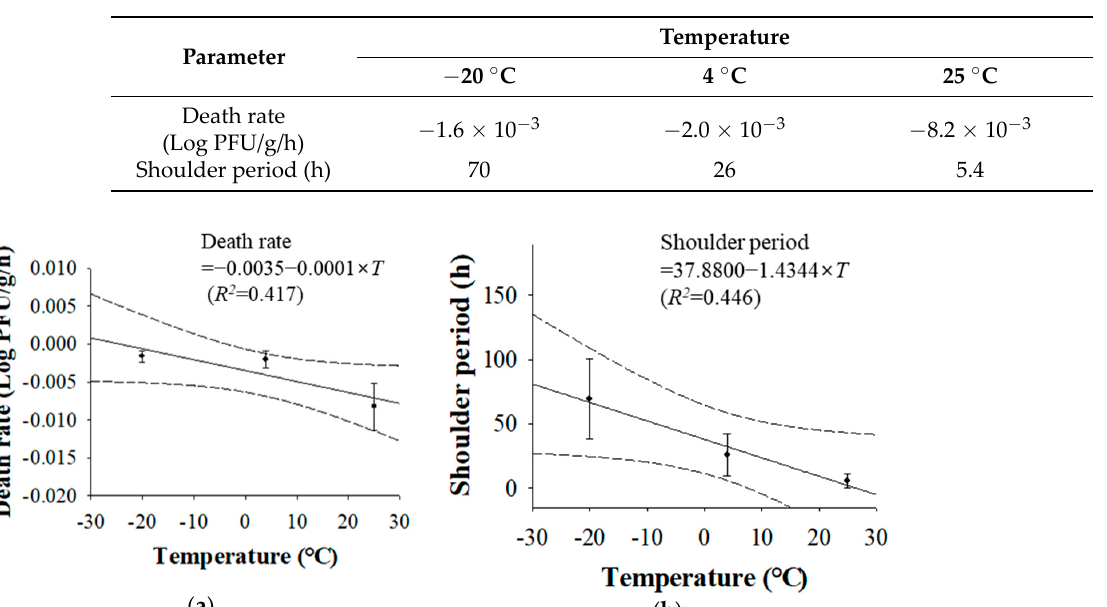
Figure 1. Hepatitis A virus death in the fermented clam during storage at − 20 º C ( A ), 4 º C ( B ), and 25 º C ( C ) with the Baranyi model (•: observed data; ― : fi tt ed line).